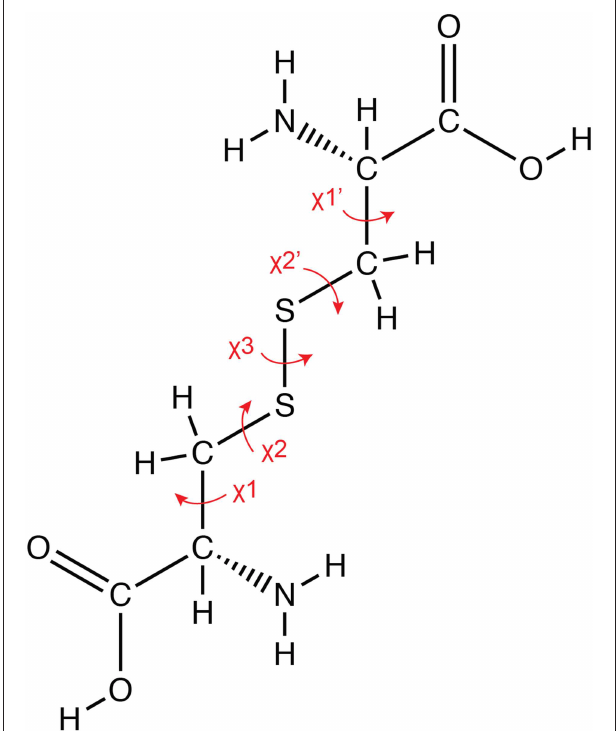
FIGURE 1 | Geometry of a disulfide bond. The covalent bond between the sulfur atoms of cysteine residues results in the formation of a disulfide bond, which involves five sidechain torsion angles as indicated in the